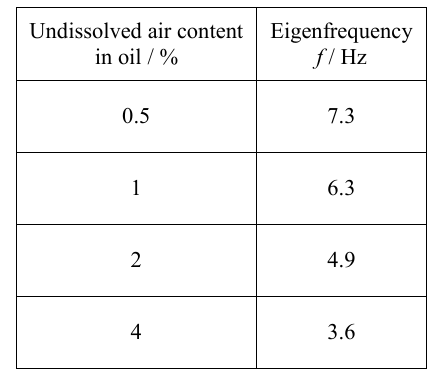
Table 1. Influence of undissolved air content on system